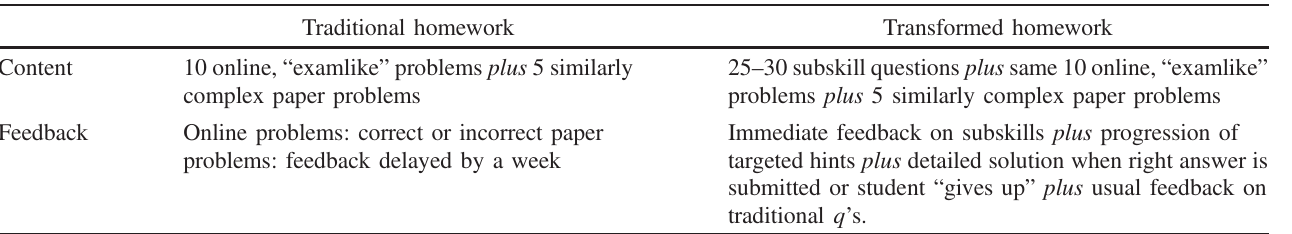
TABLE I. Comparison of traditional versus transformed homework implementation. Traditional